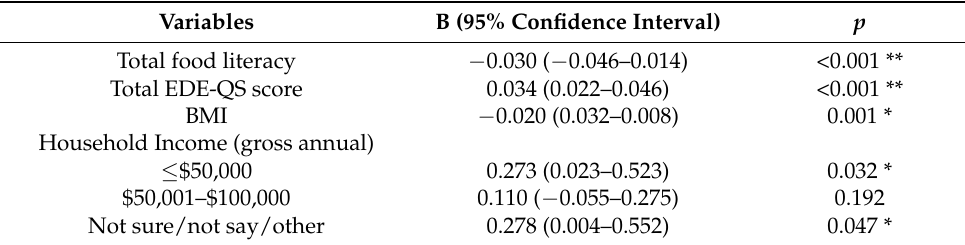
Table 3. Multiple regression analysis scoring for food literacy, eating disorder symptoms, BMI and household income predicting level of parental pressure to eat